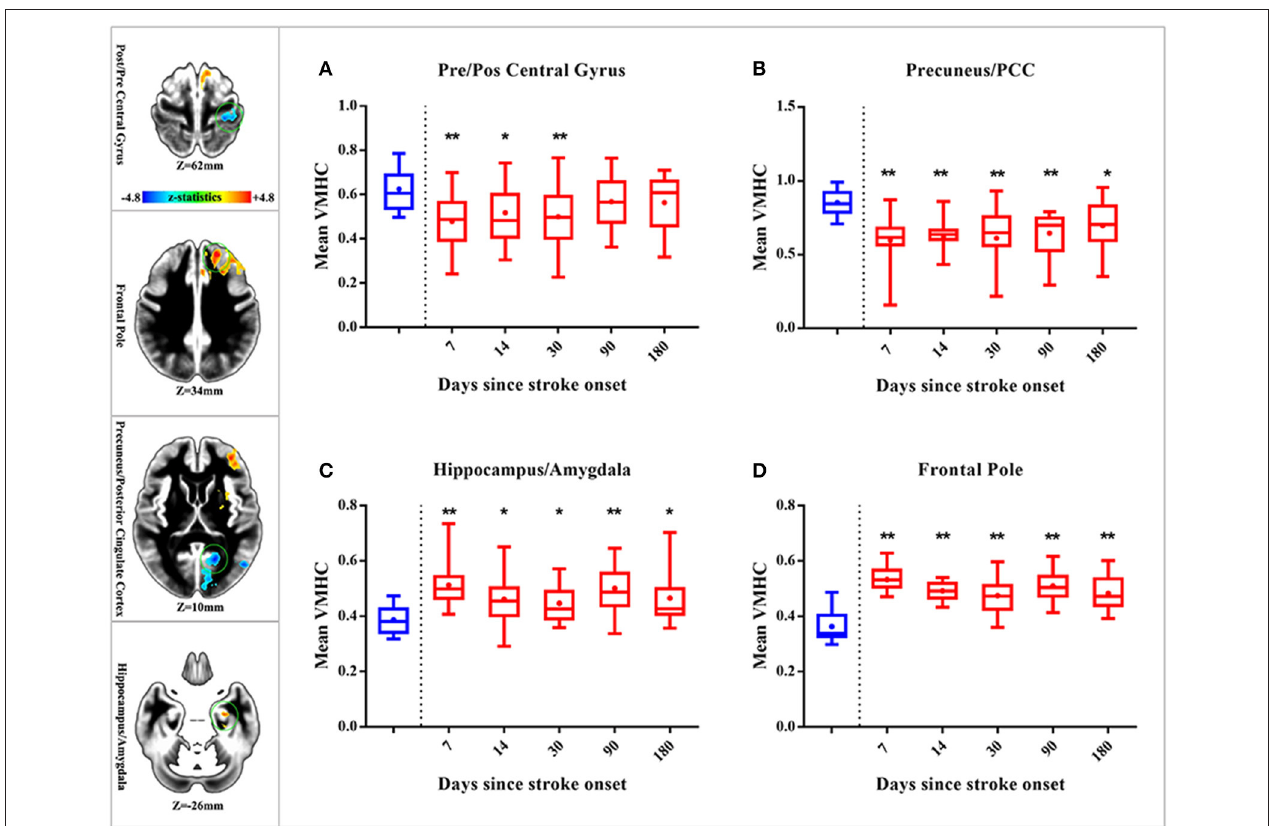
FIGURE 4 | Dynamic changes of whole-brain VMHC in patients with stroke compared with healthy controls. The 4 axial slices on the left vertical row show the position of brain areas (marked with a green circle) with significant VMHC differences in patients with early stroke (located in the precentral and postcentral gyrus, precuneus/PCC, hippocampus/amygdala and frontal pole, respectively). Warm color indicates increased VMHC, while cold color indicates decreased VMHC. The 4 box plots on the right show time-dependent changes in 4 brain regions [precentral and postcentral gyrus (A) precuneus/PCC (B) hippocampus/amygdala (C) frontal pole (D) ] over 5 time points (within 7 days, 14 days, 30 days, 90 days, and 180 days after stroke onset). Red boxes indicate the mean VMHC of patients with stroke, while blue boxes indicate that of healthy controls. “**” represents significant differences between patients and HC at a threshold of P < 0.01; “*” represents a threshold of P < 0.05. VMHC, voxel-mirrored homotopic connectivity; HC, healthy controls; PCC, posterior cingulate